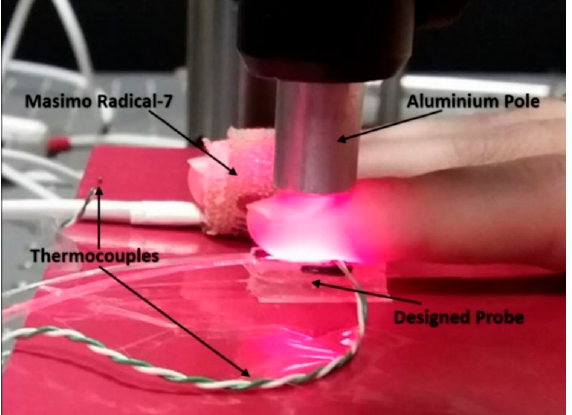
Figure 4. The patch beneath the index finger is the designed epoxy probe. The commercial sensor is taped on the middle finger. Two thermocouples are used to measure the environment and the index finger